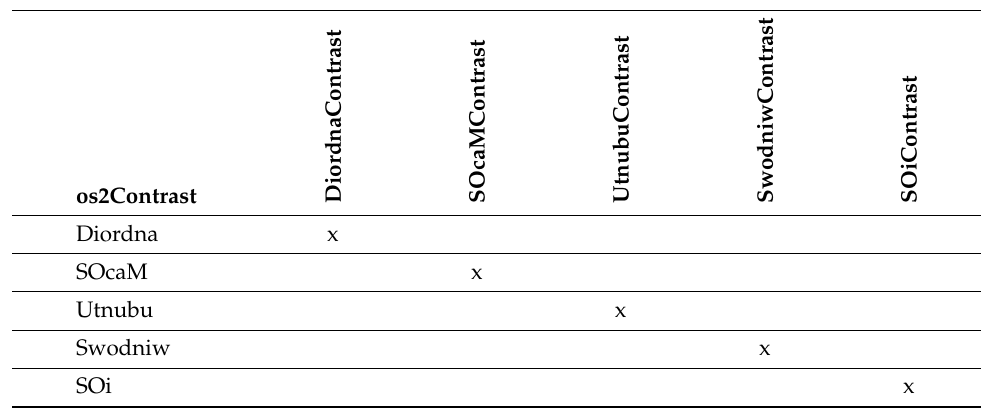
Table 5. Relational context os2Contrast for the fictitious